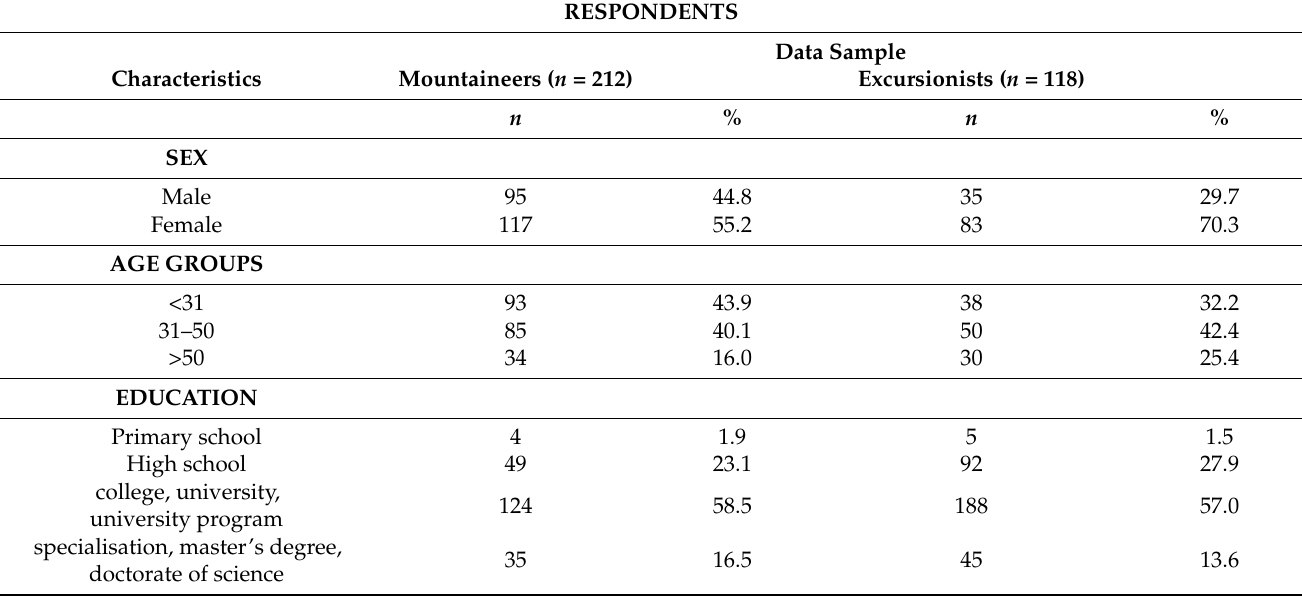
Table A1. Demographic characteristics of respondents and